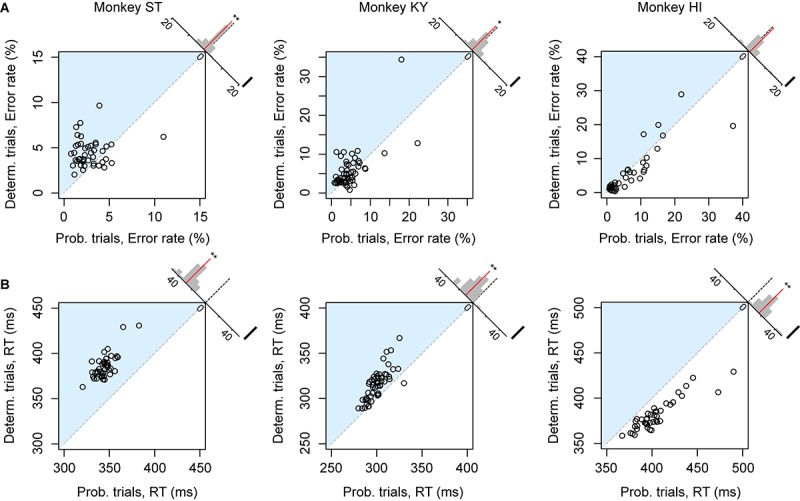
Risk-induced behavioral bias. (A) Error rate of each session. Error rates in probabilistic trials (abscissa) and in deterministic trials (ordinate) in each session are plotted for monkeys ST (left), KY (center), and HI (right). The plots in the blue shaded areas indicate risk-prone sessions. Histograms on the right shoulder of panels show the distribution of the distance between each plot and the identity line. Red lines indicate the average of the distance. Asterisks indicate significant difference from zero (∗∗p < 0.01, *p < 0.05, rank-sum test). (B) Reaction time (RT) of each session. Schemas of the figures are the same as in A.